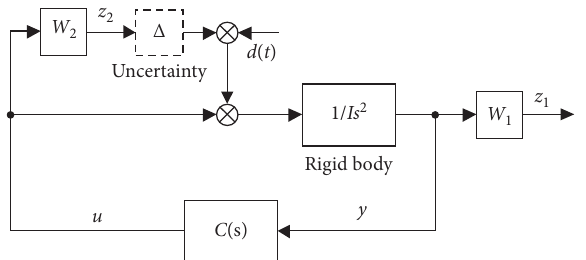
Figure 4: Block diagram of the system structure with